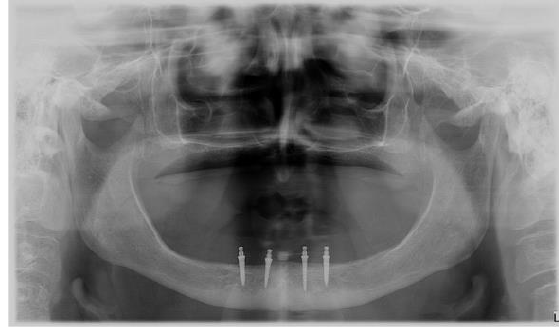
Figure 1. Preoperative panoramic